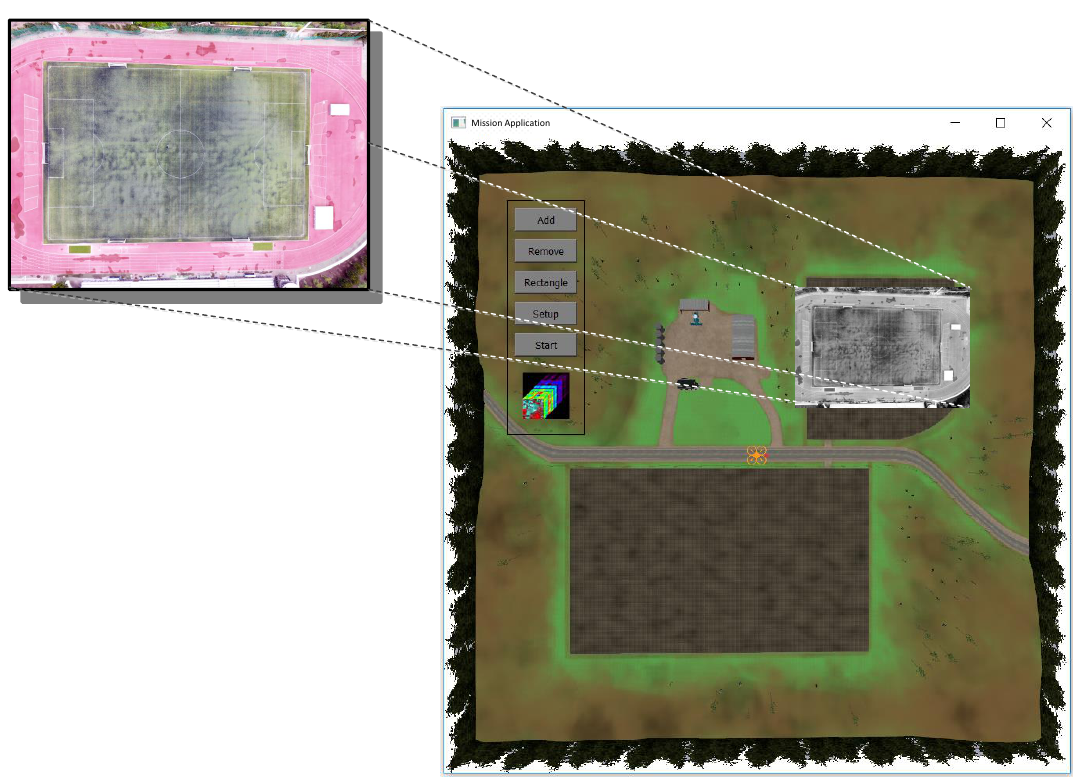
Figure 10. Image of the football field located at the University of Las Palmas de Gran Canaria campus. Image taken with a Phantom 4 drone from the drone manufacturer, DJI, at a height of 80